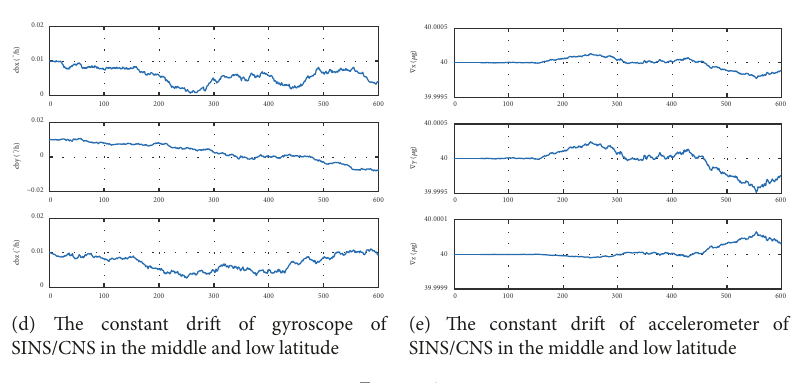
(e) The constant drift of accelerometer of SINS/CNS in the middle and low latitude Figure 2